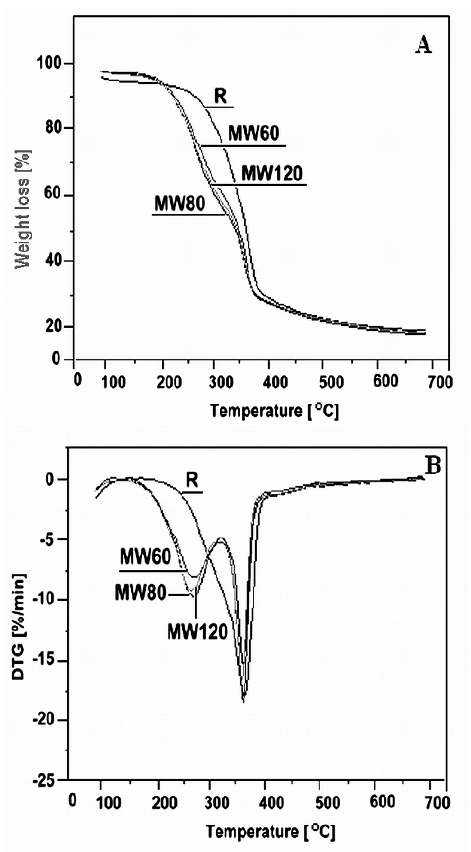
Figure 5. TG and DTG curves recorded at 10 K min −1